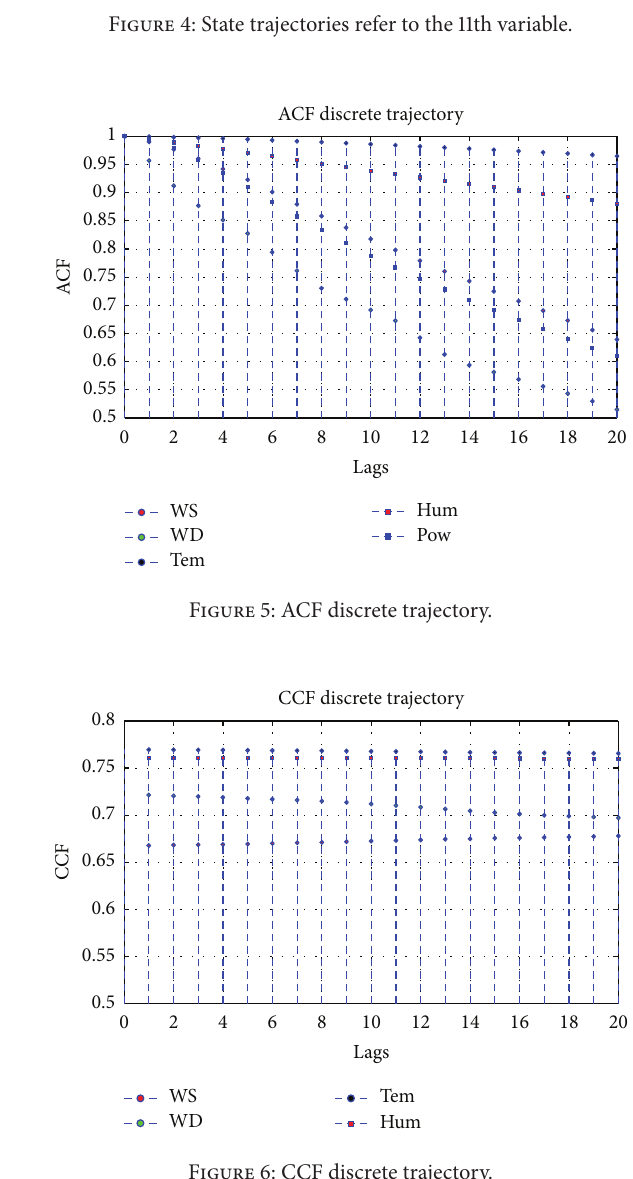
Figure 6: CCF discrete